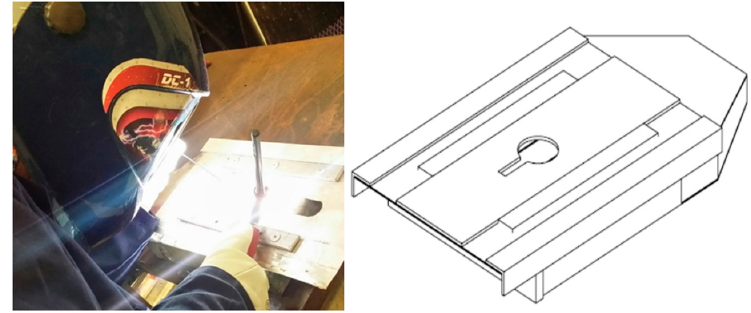
Figure 1. Inert gas chamber design ( right ) and welding process ( left ).